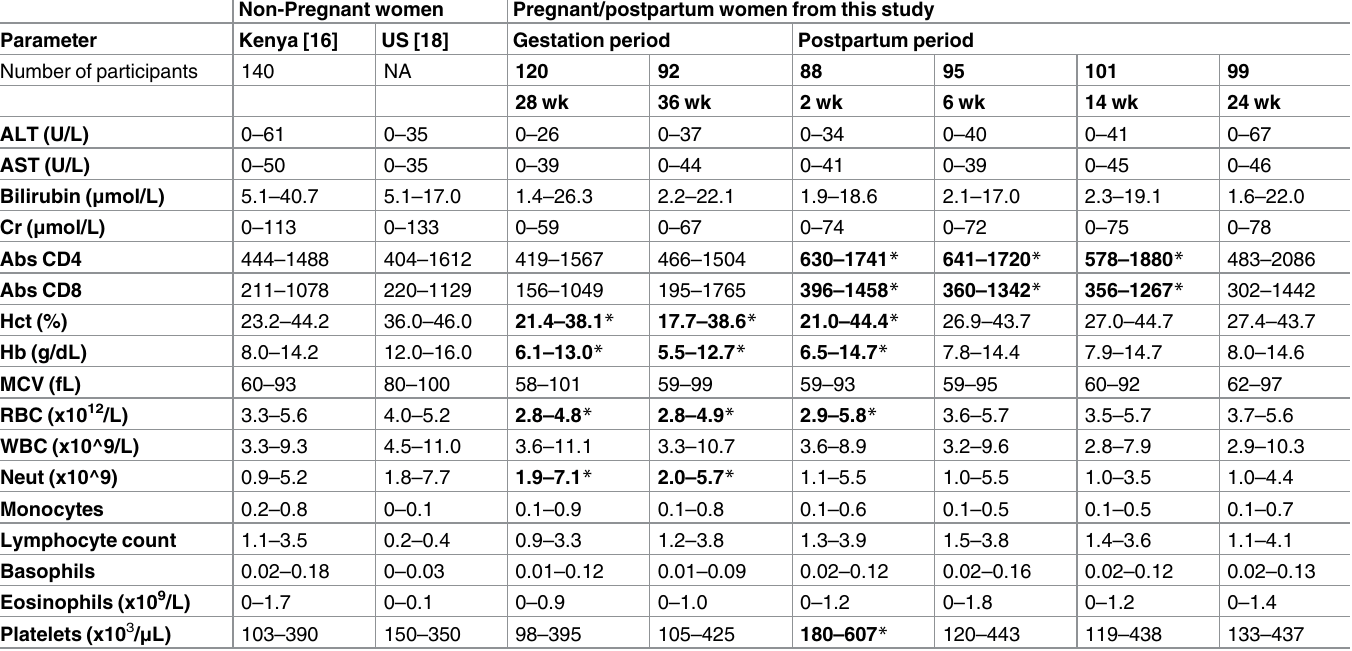
Table 1. Referenceintervals for immune-hematological and biochemistry parameters for HIV uninfected women during pregnancy and postpar- tum compared to non-pregnant women. Kenya and United States,